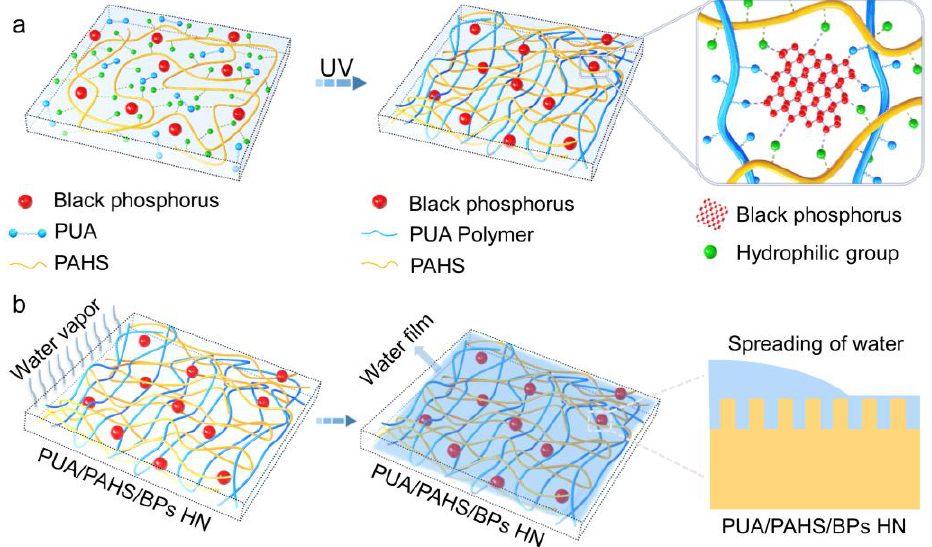
Figure 1. Schematic diagram of design of BP hybrid polymer HN coating for effective an tifogging performance. ( a ) Synthesis of PUA/PAHS/BPs HN. ( b ) Antifogging mechanism of PUA/PAHS/BPs HN.